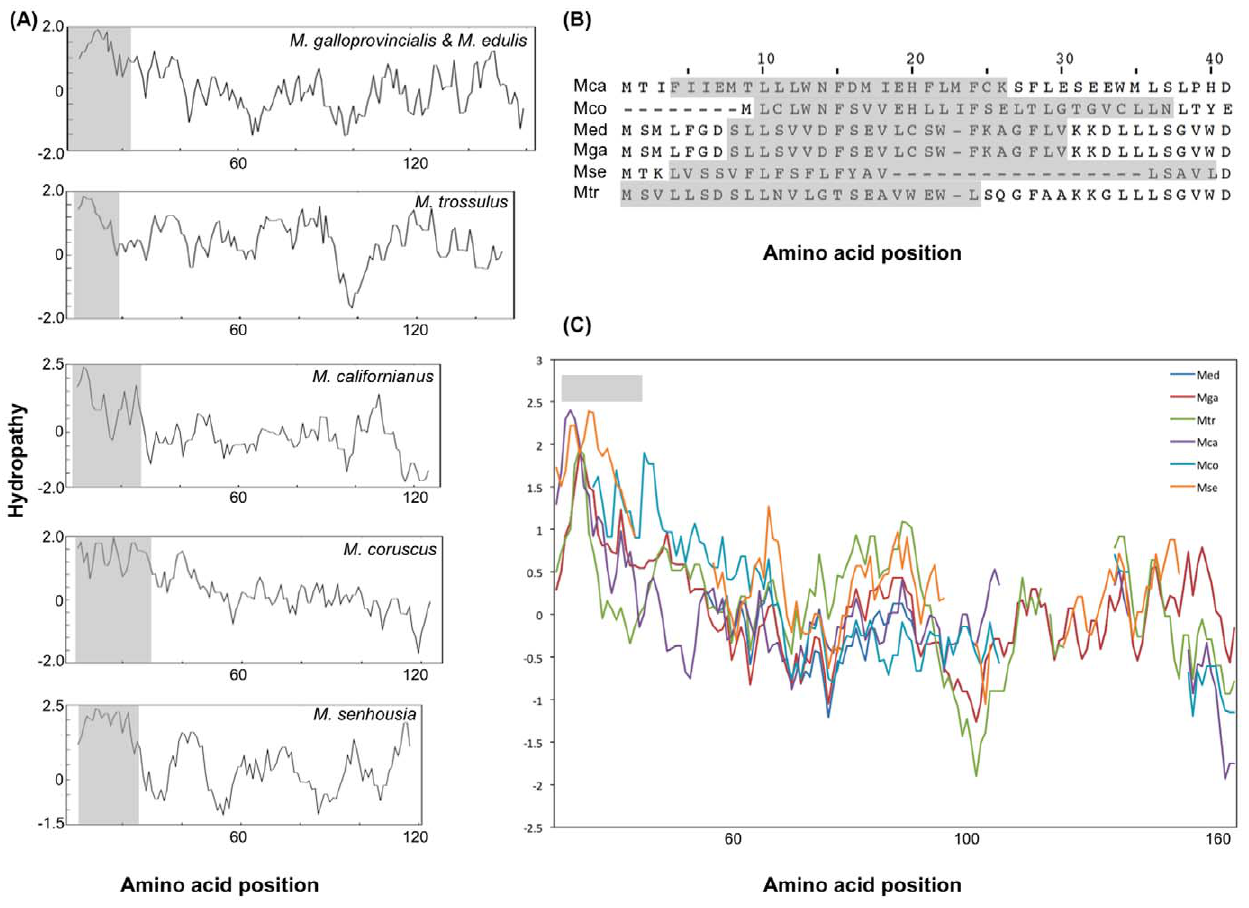
Figure 4. Comparisons of Mytilus spp. F- ORF-VD1 and M.senhousia F- ORF hydropathy profiles. (A) Profiles for each species were calculated by the method of Kyte and Doolittle [104]. Numbers below profiles designate amino acid positions in each protein. Predicted transmembrane domains according to TMpred [102] (all with significant scores . 500) are shown in light gray (It has to be noted that a single TMH in the N terminal portion of each F- ORF proteins has also been identified using HMMTOP [101]). (B) T-COFFEE alignment of the translated N terminal portions of mytilid F-specific ORF sequences. Predicted transmembrane domains according to TMpred [102] are shown in light gray. (C) Kyte and Doolittle profiles for the F- ORF protein alignment with the homologous amino acid sites in the same position on the x axis. The predicted transmembrane domain according to TMpred [102] is shown in light gray. Mca, M. californianus ; Mco, M. coruscus ; Med, M. edulis ; Mga, M. galloprovincialis ; Mse, M. senhousia ; Mtr, M. trossulus